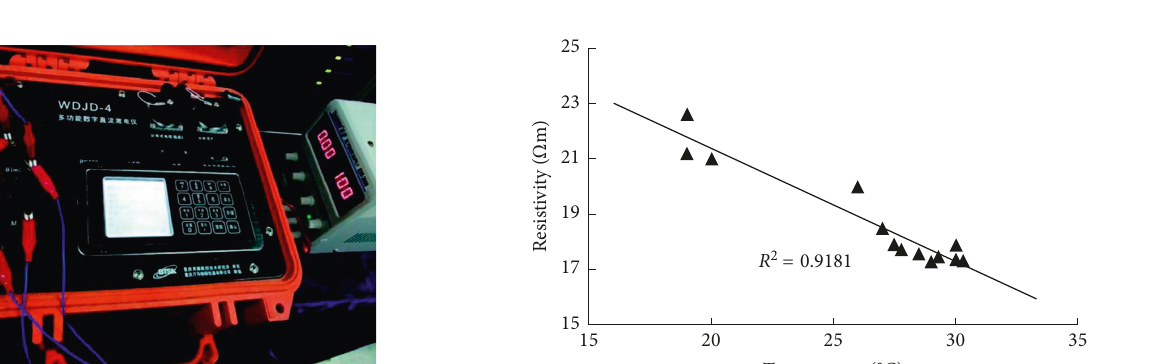
Figure 4: Temperature correction curve for soil sample